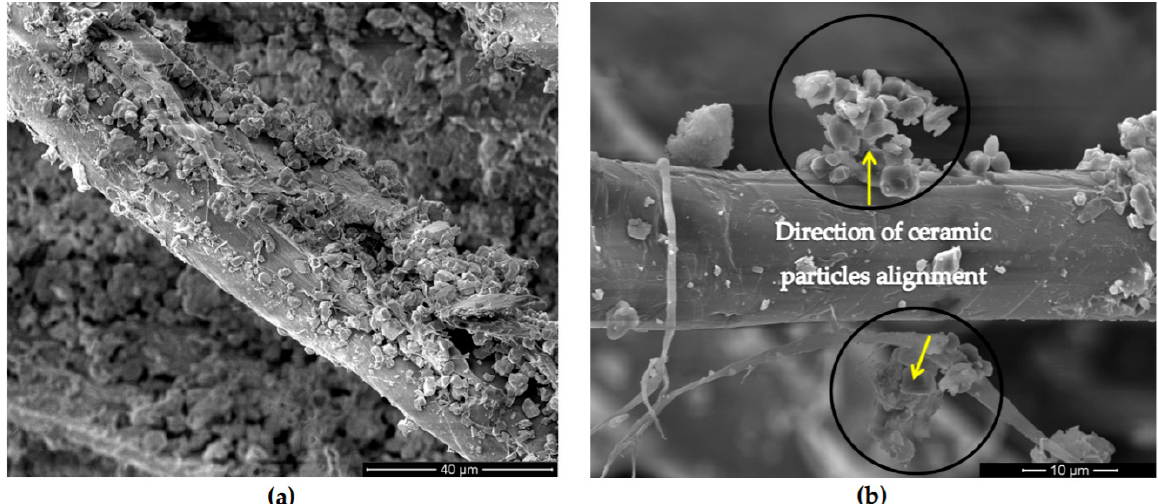
Figure 18. SEM images of the fracture surface of the PALF composite after the ballistic test: ( a ) PALF impregnated with ceramic aggregates; ( b ) alignment of ceramic aggregates on PALF surface. (Adapted with copyright permission from Da Luz et al. [134]).